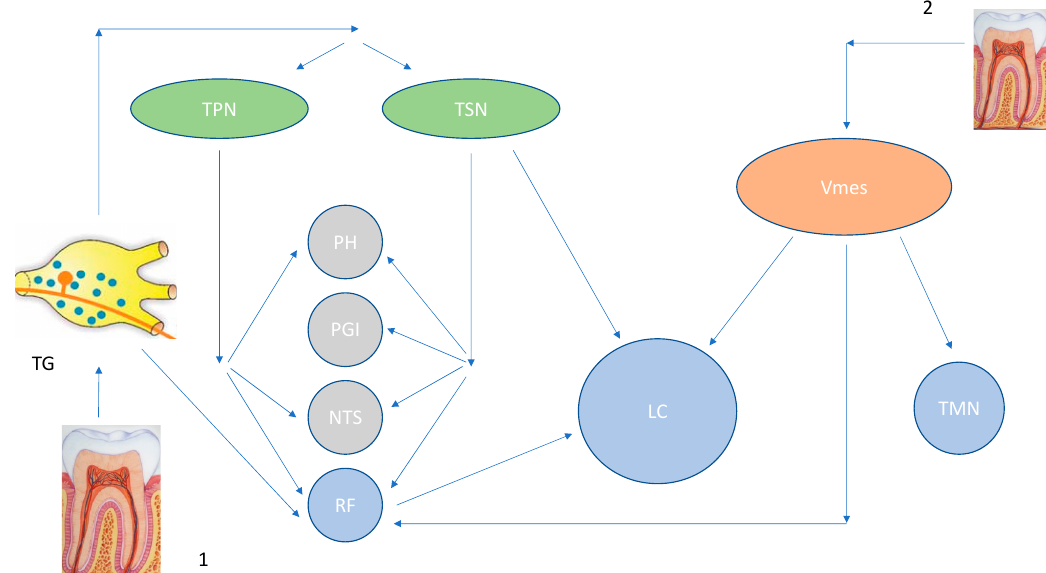
Figure 1. [131]: Trigeminal Pathways to Brainstem structures. Legenda: TG: Trigeminal Ganglion, TPN: Trigeminal Principal Nucleus, TSN: Trigeminal Spinal Nucleus, PH: Prepositus Hypoglossi, PGI: Nucleus Paragigantocellularis, NTS: Nuclues of Tractus Solitarius, RF: Reticular Formation, Vmes: Trigeminal Mesencephalic Nucleus, LC: Locus Coeruleus, TMN: Tuberomammillary Nu- cleus, 1: Somato-sensory and Periodontal Ligament/Pulpar afferents, 2: Proprioceptory Periodontal Ligament afferents.